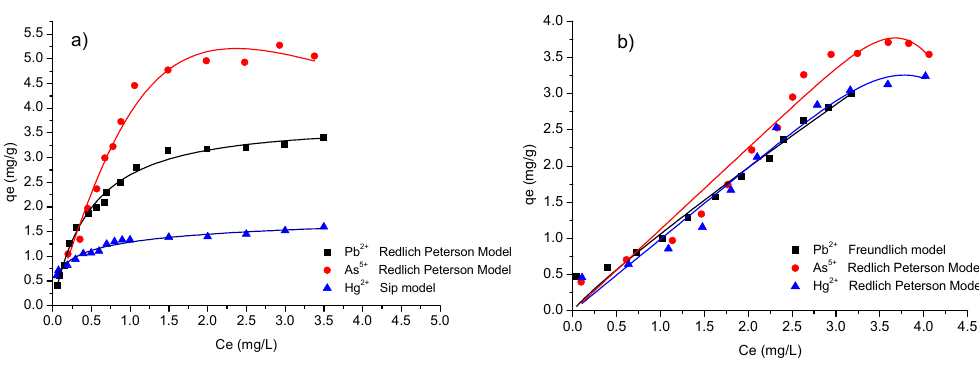
Figure 4. Isotherms of ( a ) Eggshell and the ( b ) nanocomposite for Pb 2+ As 5+ and Hg 2+ removal (The symbols represent experimental data while lines are the best-fit mathematical model according to R 2 ). Table 2. Parameters of isotherms model for Pb 2 + As 5 + and Hg 2 + onto Eggshell and composite. Eggshell [Eggshell / Ag-Fe] Parameters